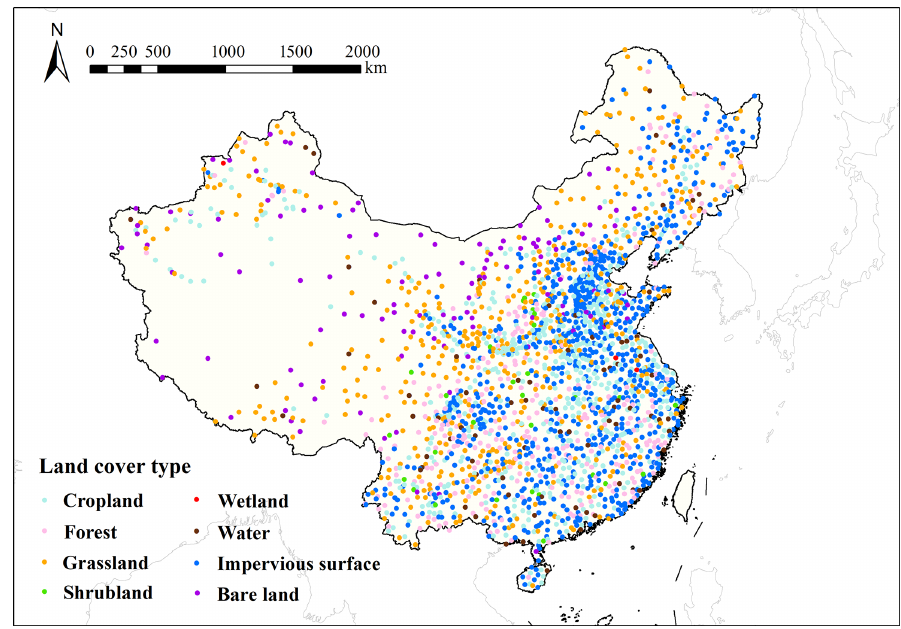
Figure 1. Study area and the location of meteorological stations used in this study. Each dot represents a station, and different colors correspond to different land cover types as shown in this figure legend. Table 1. The satellite datasets used in this study. Product Dataset(s) Spatial resolution Temporal resolution Land surface temperature (LST) MOD11A1, MYD11A1 1km Daily Downward shortwave radiation (DSR) GLASS05B01 0.05 ◦ Daily Surface albedo (ALB) GLASS02A06 1km 8d Leaf area index (LAI) GLASS01A01 1km 8d Elevation GMTED2010 15arcsec